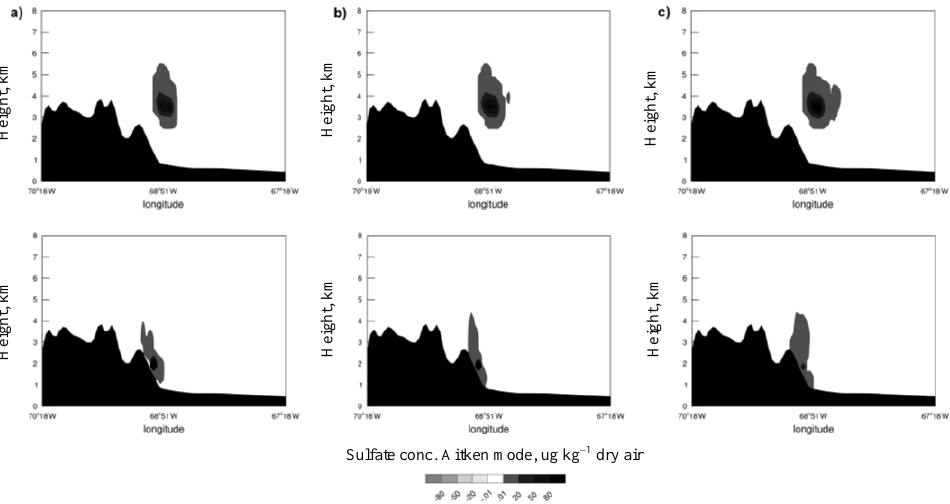
Fig. 9. Cross-sectional profile by longitude and height of Aitken-mode SO 42 − concentration anomaly calculated as ID1 − Test_Control at 4 km a.s.l. (upper panel) and ID2 − Test_Control at 2 km a.s.l. (lower panel), taken at latitude of 32  54' S (see dotted line in Fig. 1(b)), for January 8, 2012 at: a) 9:00 LT; b) 10:00 LT; c) 11:00 LT.